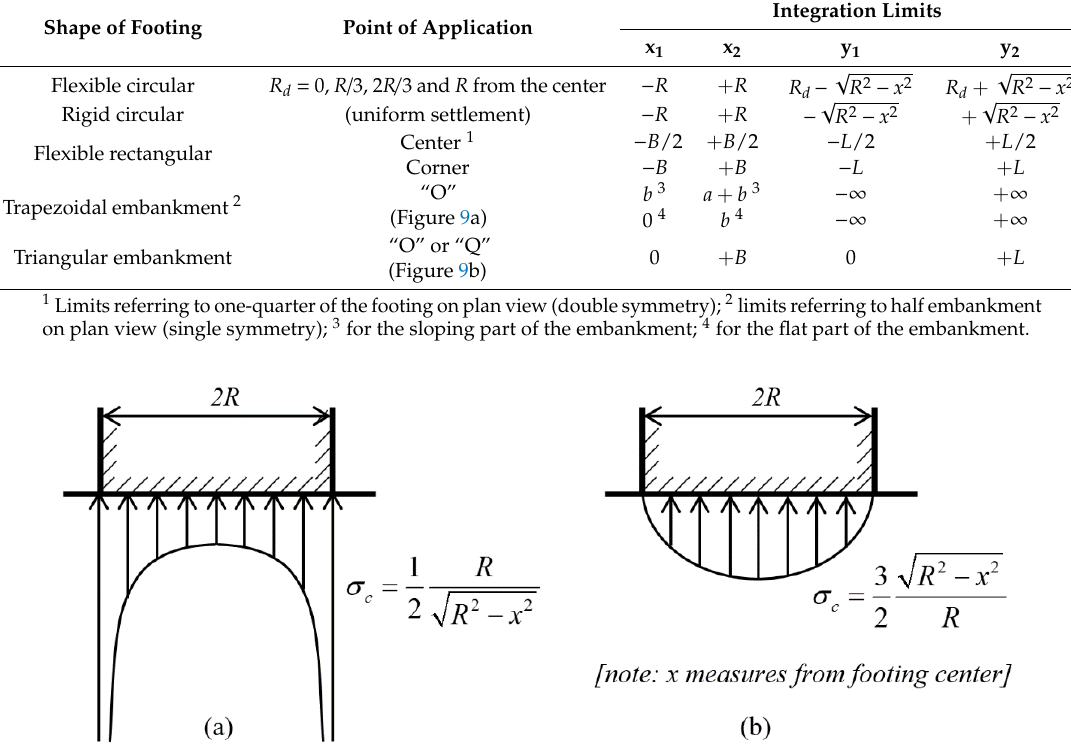
Table 1. Integration limits for Equation (4).